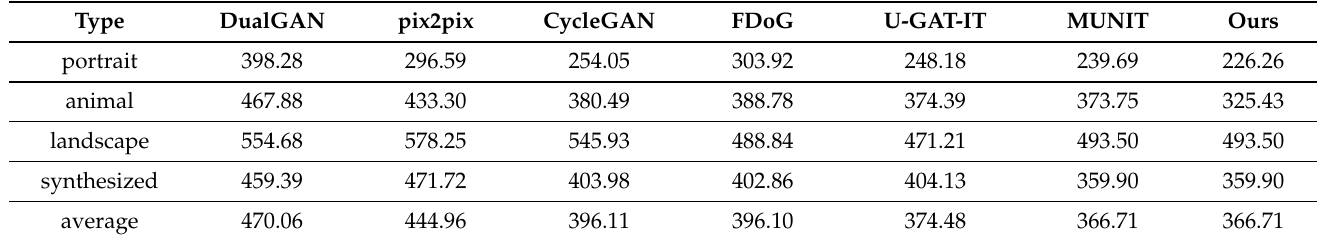
Table 5. The FID values estimated from the images in Figures 11 and 12.